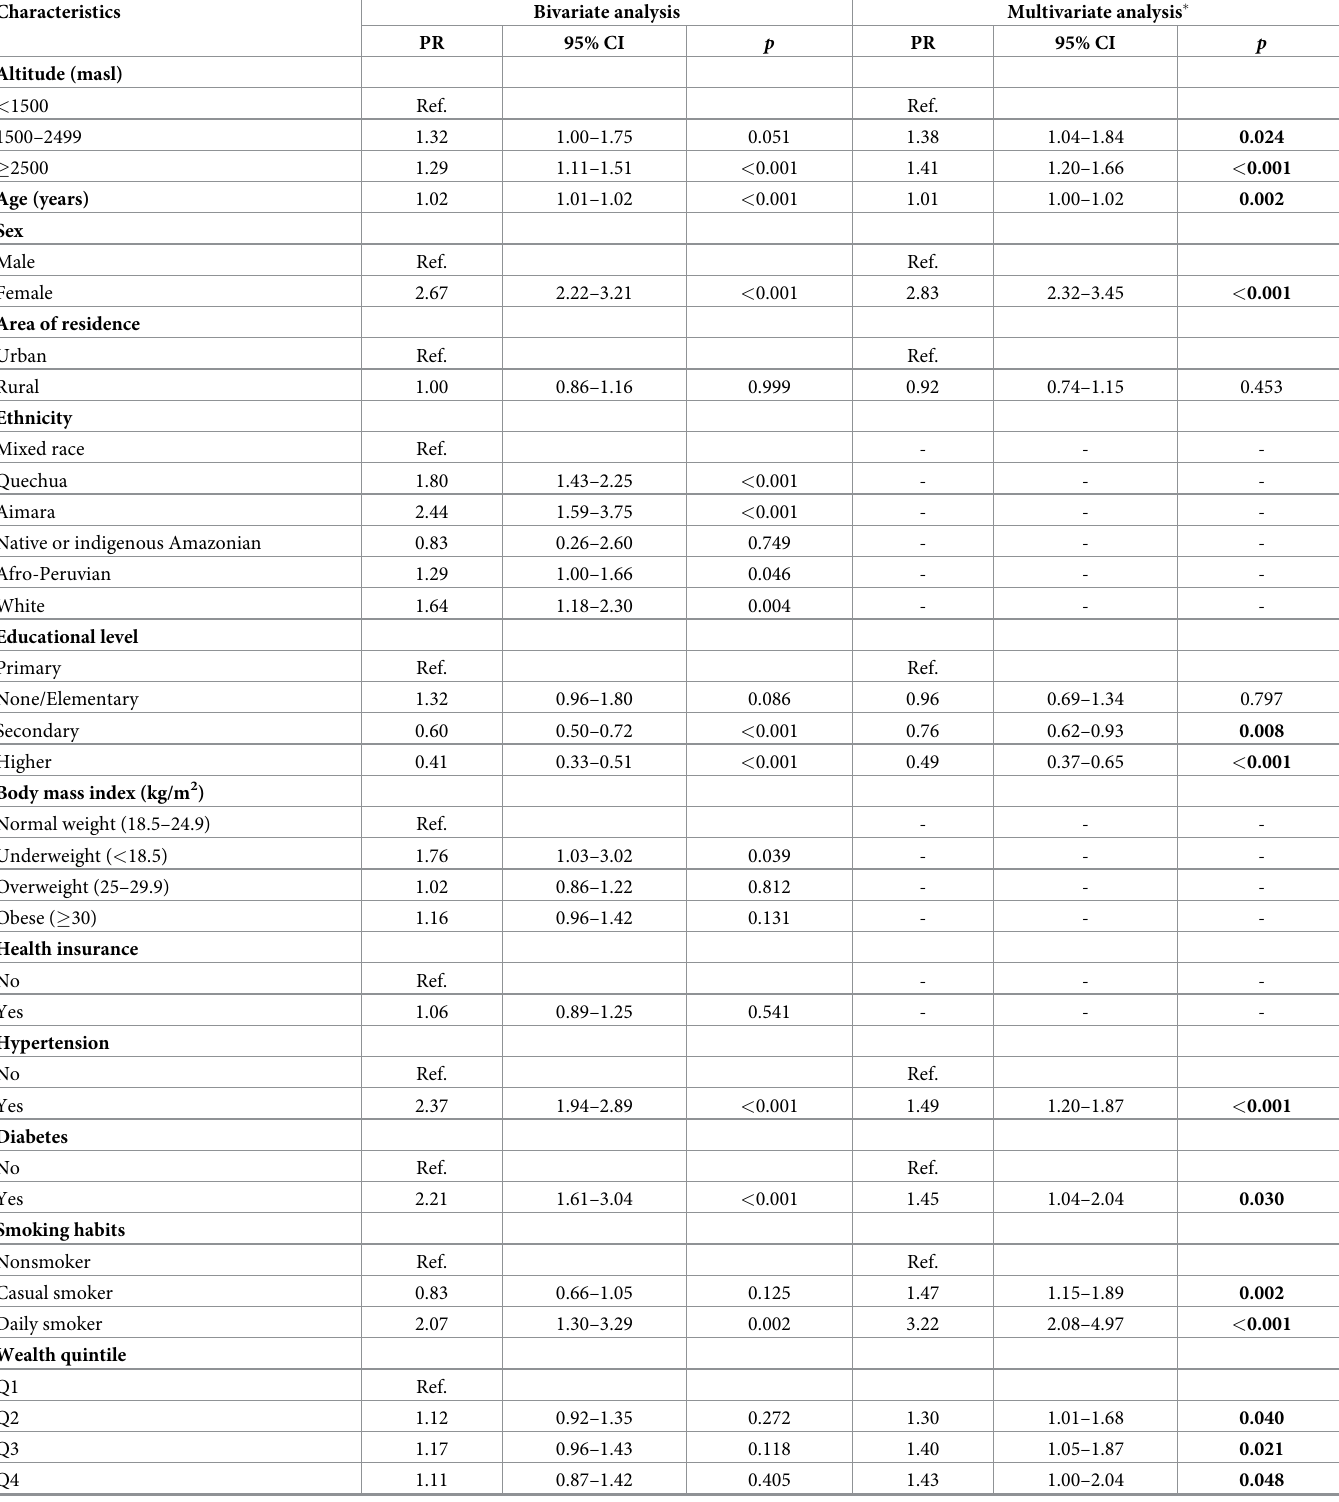
Table 3. Regression results on the association between altitude and presence of depressive